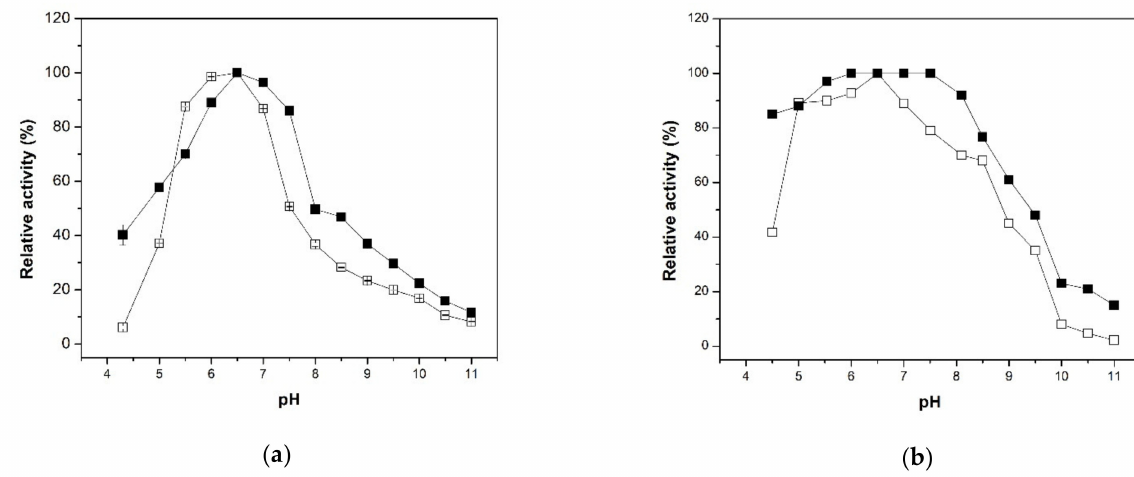
Figure 5. Effect of pH on the activity and stability of the free XynB2 Y509E and immobilized XynB2 Y509E -CLEAs. ( a ) Effect of pH on β -xylosidase activity of the free XynB2 Y509E ( (cid:1) ) and immobilized XynB2 Y509E -CLEAs ( (cid:4) ) when the reactions were performed in CFG buffer (0.1 M) and 50 ◦ C using the chromogenic assay described in the experimental section. Relative activity was referred to the highest activity of the enzyme. ( b ) Effect of pH on enzyme stability of the free XynB2 Y509E ( (cid:3) ) and immobilized XynB2 Y509E -CLEAs ( (cid:4) ) when the reactions were performed at 50 ◦ C after the enzymes were incubated for 1 h at the indicated pH using as substrate p-NPX 2.2 mM, pH 6.5. Relative activity was referred to the initial activity of the enzyme, prior to any incubation using the standard activity assay.